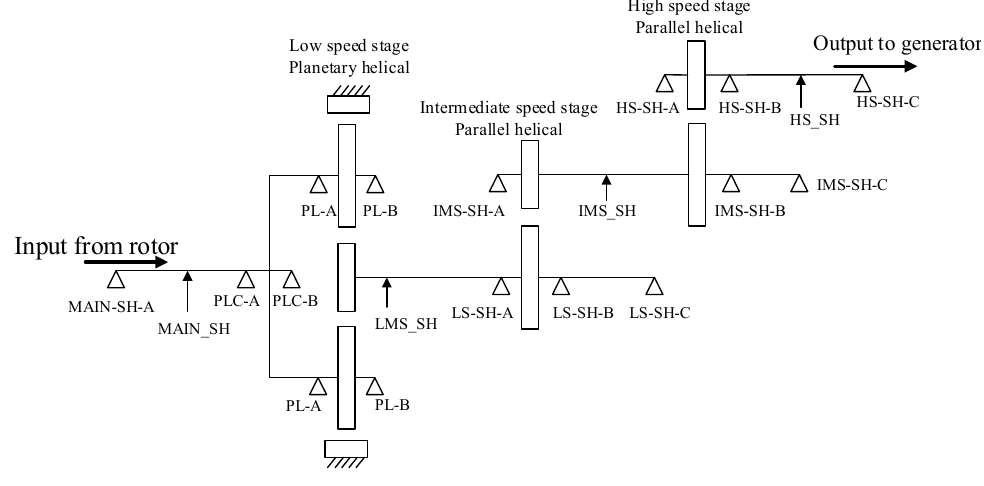
Figure 2. The topology of the gearbox.